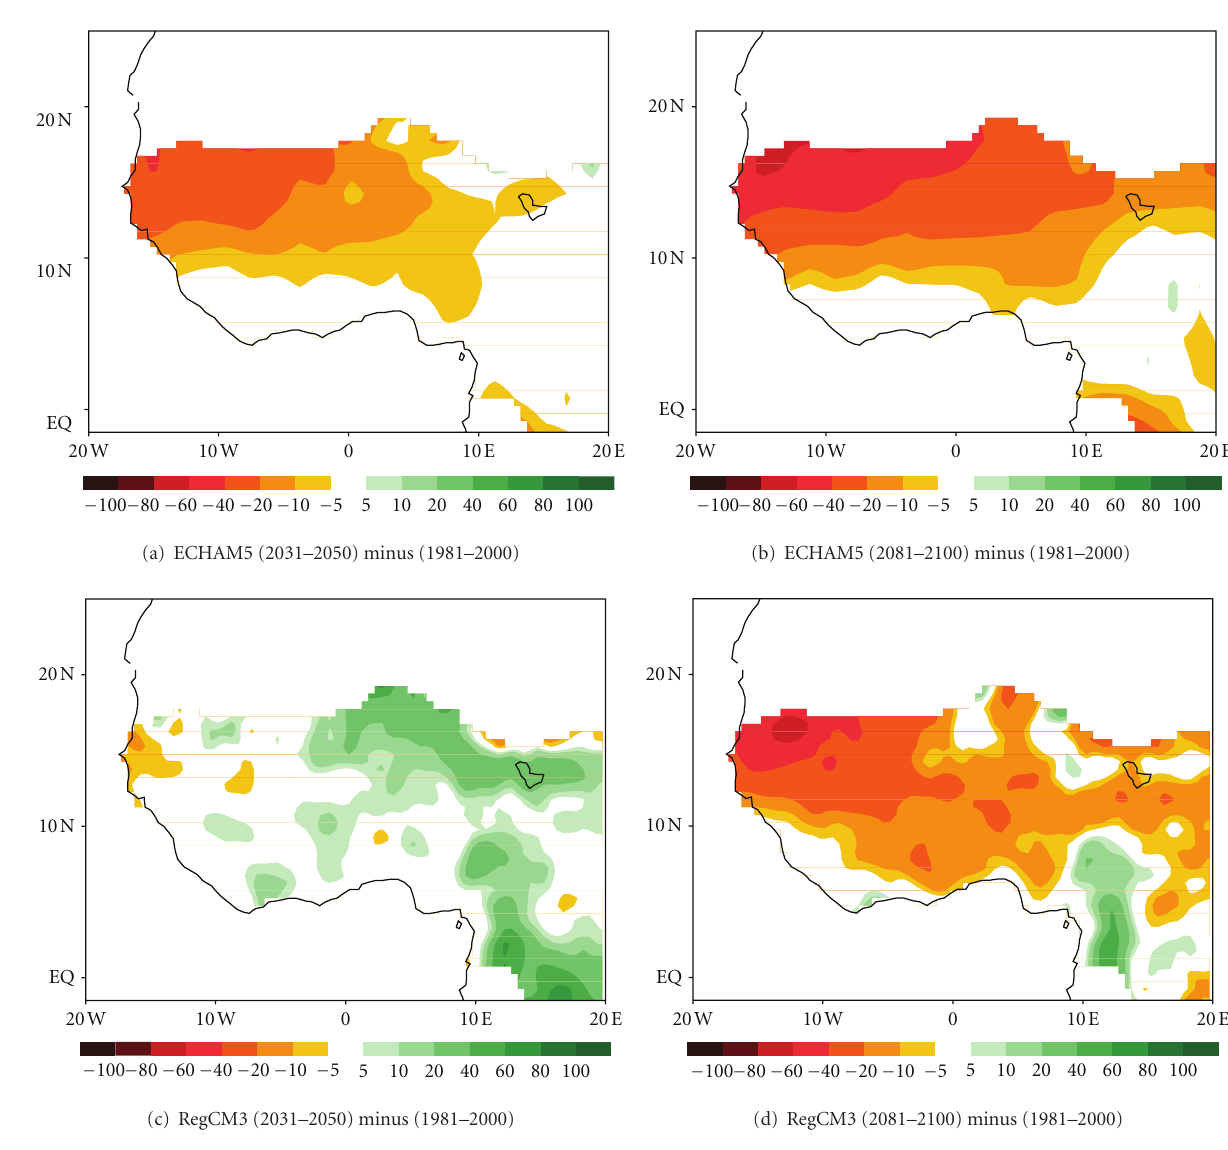
Figure 6: The same as Figure 5 but for the frequency of wet